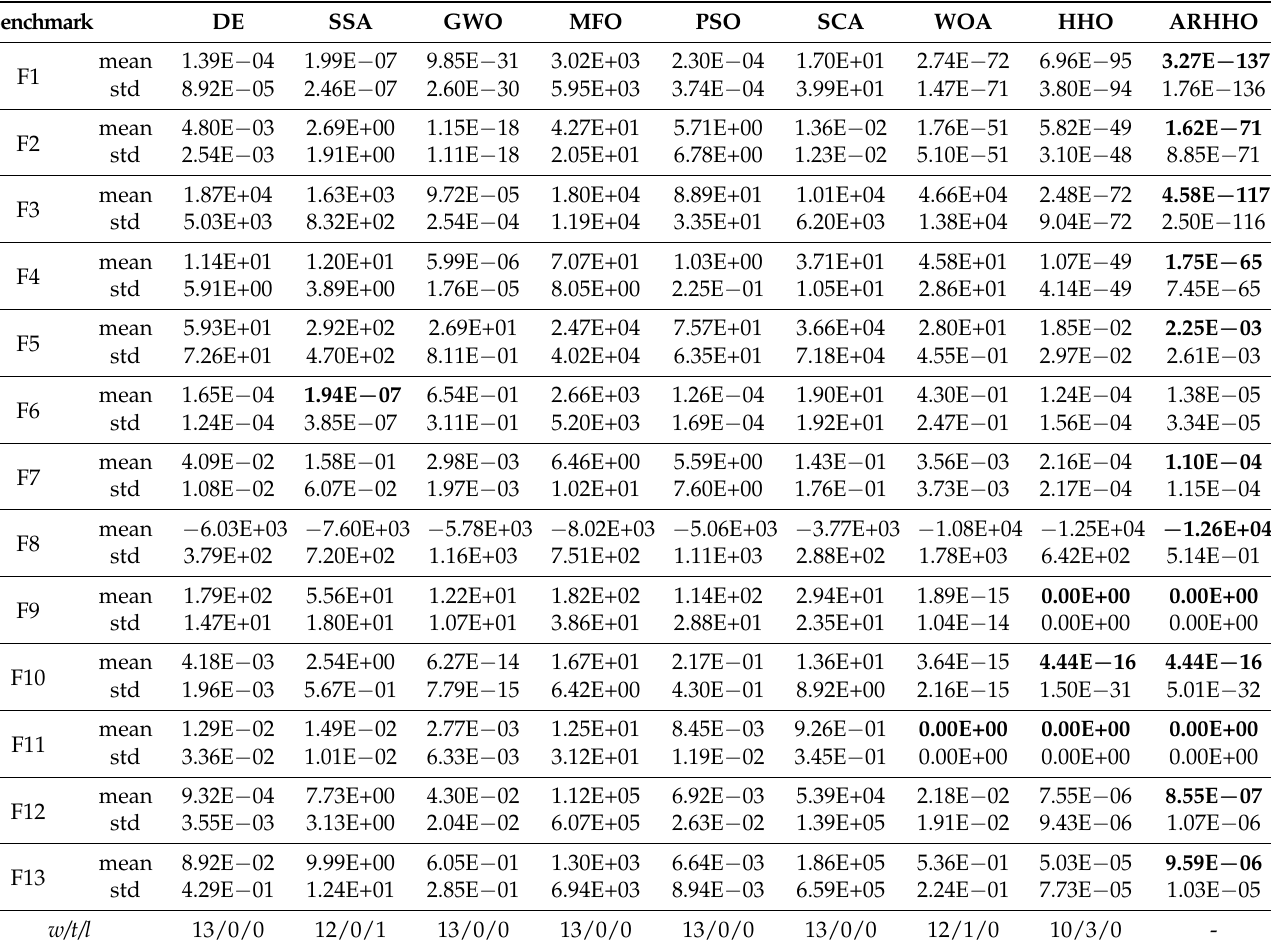
Table 2. Experimental results of benchmark functions F1~F13 in 30